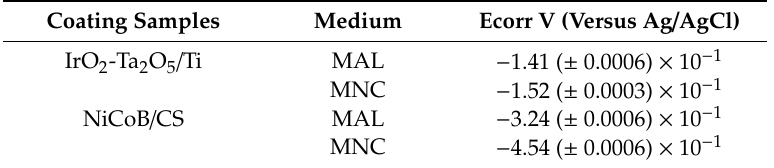
Figure 4. Polarization curves in Ca(OH) 2 and NaCl 3.5 wt% media for the ( a ) NiCoB/CS and ( b ) IrO 2 - / Ti coatings. Ta 2 O 5 /Ti coatings. IrO 2 -Ta 2 O 5 Table 3. Corrosion potential values for the NiCoB / CS and IrO 2 -Ta 2 O 5 / Ti